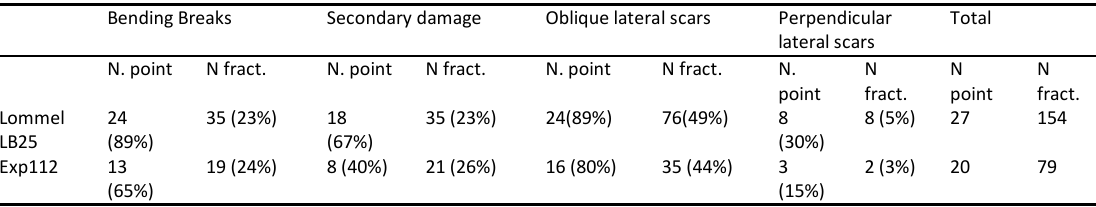
number of fractures between the identified projectile elements of Lommel-Maatheide and the new experimental